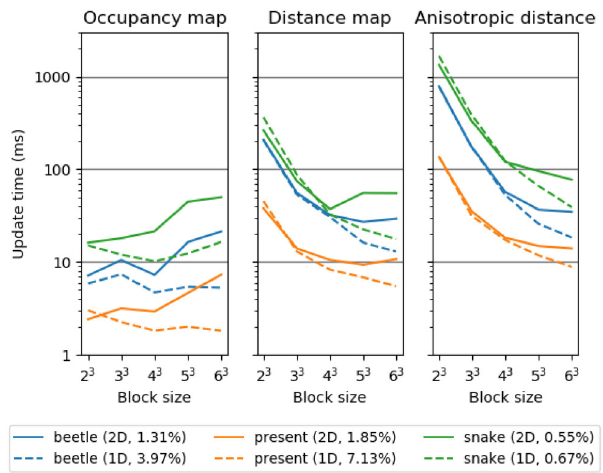
Fig. 5 Update time for occupancy and distance maps for the evaluated images with several cubic block sizes. Distance map update time is inclusive of the occupancy map update